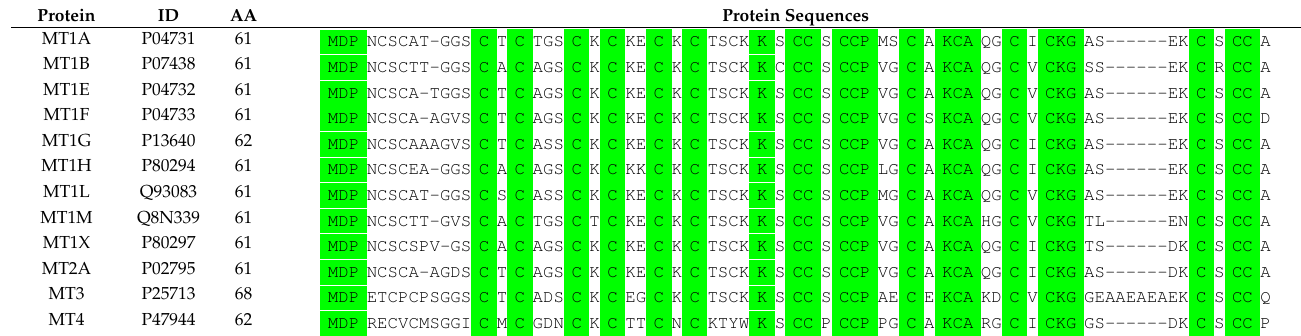
Table 1. Human metallothionein (MT) protein sequences. AA: amino acids. Conserved residues between all human MT proteins are highlighted in green. Sequence alignment was performed using the Align tool of the Uniprot database.